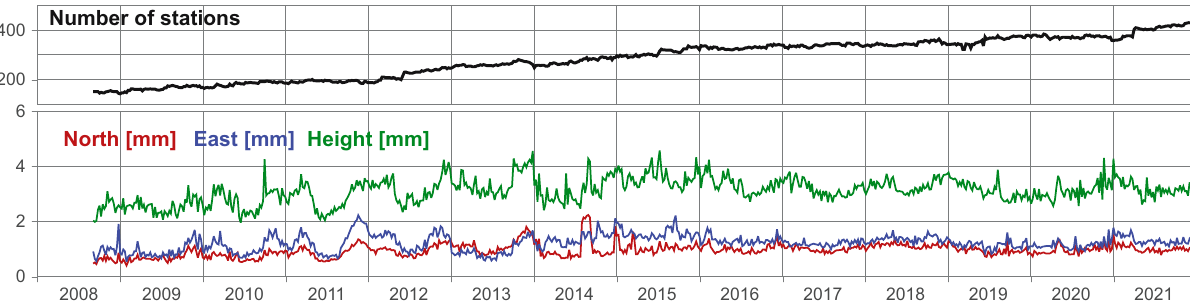
Figure 4: Mean RMS values of the station position repeatability between the SIRGAS individual solutions. The upper panel shows the number of processed